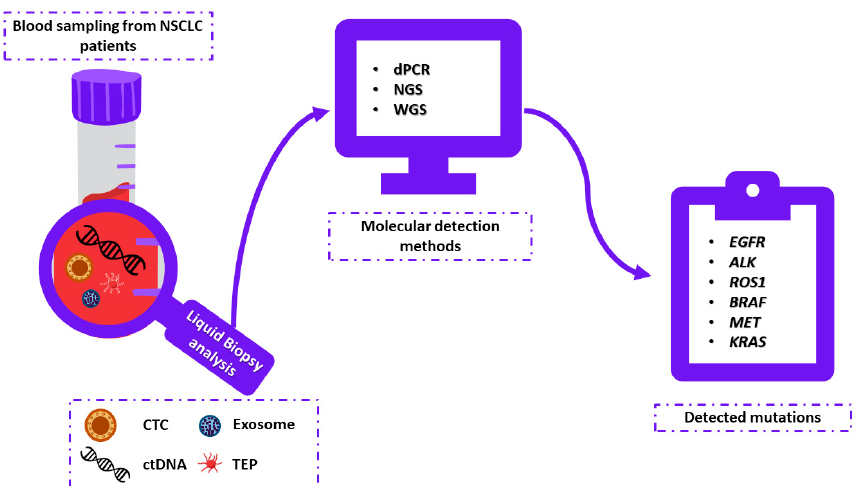
Figure 2. Liquid biopsy analysis as a diagnostic tool for TKI-based treatment in non-small cell lung cancer. In peripheral blood samples, liquid biopsy elements such as circulating tumor cells (CTCs) and/or cell-free DNA (cfDNA) and/or tumor-educated platelets (TEPs) and/or exosomes can be detected. Mutations ( EGFR , ALK , ROS1 , BRAF , MET, KRAS ) detected in liquid biopsy elements using molecular detection methods (e.g., next generation sequencing (NGS), digital PCR (dPCR), shallow whole genome sequencing (sWGS)) correspond to the results obtained during traditional tissue biopsy.